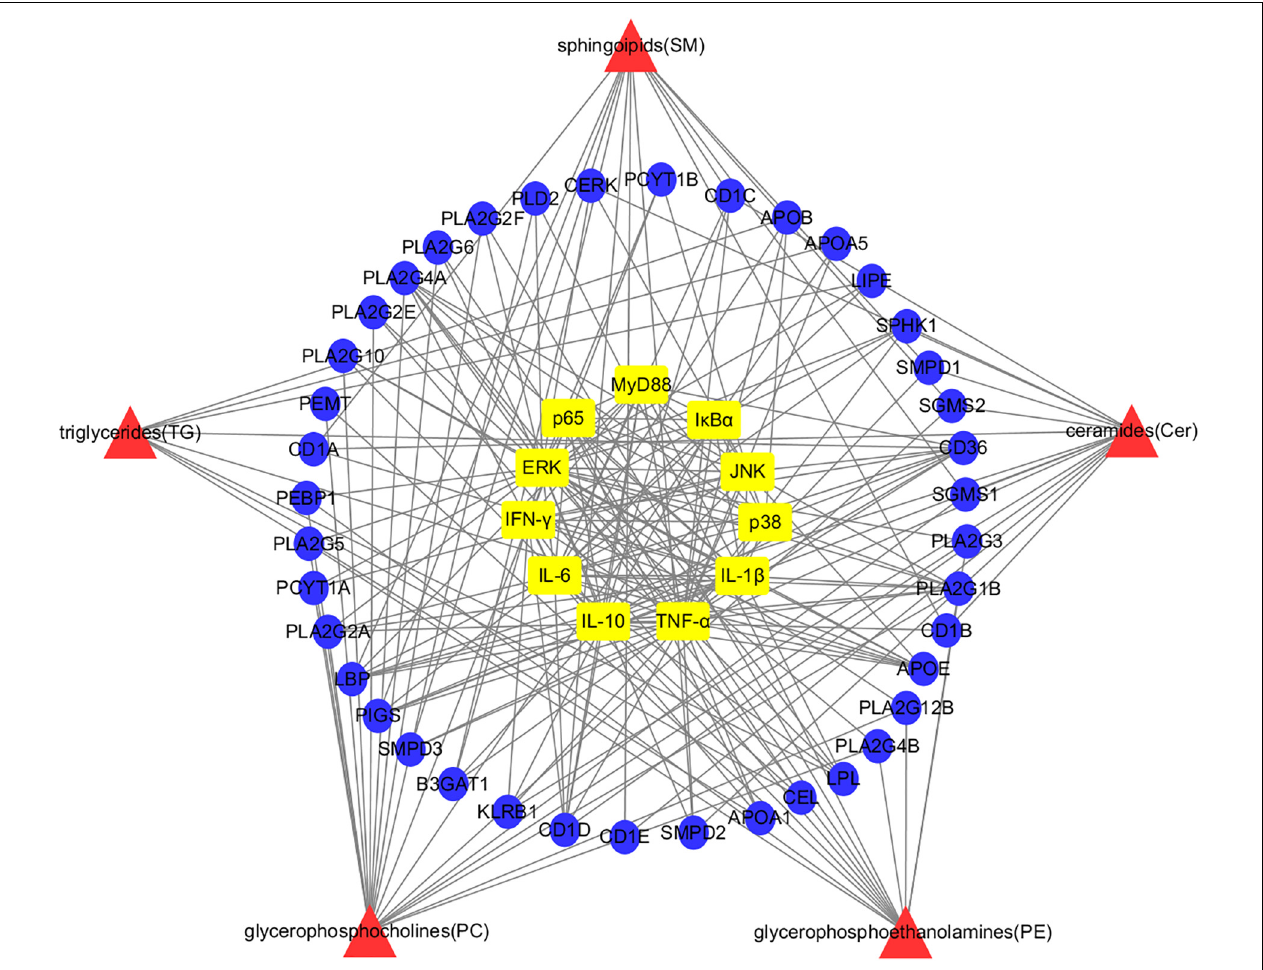
FIGURE 8 | Network visualization analysis of “potential lipid markers-lipoproteins-TLR4/MyD88 signaling pathways” for anti-inflammatory effects of HLJDD. Red area: differentially expressed species of lipid markers; Blue area: corresponding lipoproteins of lipid markers; Yellow area: cytokines and proteins of the TLR4/MyD88 signaling